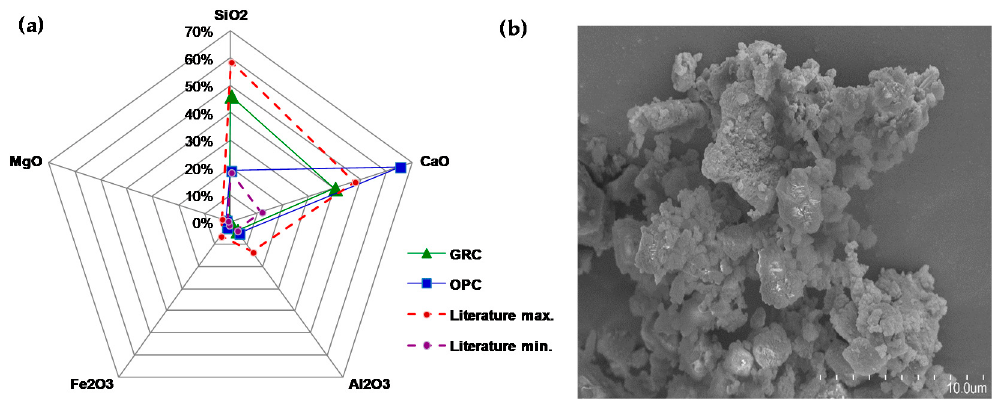
Figure 1. ( a ) Chemical composition of ground recycled concrete (GRC) and ordinary Portland cement (OPC); and ( b ) GRC morphology.